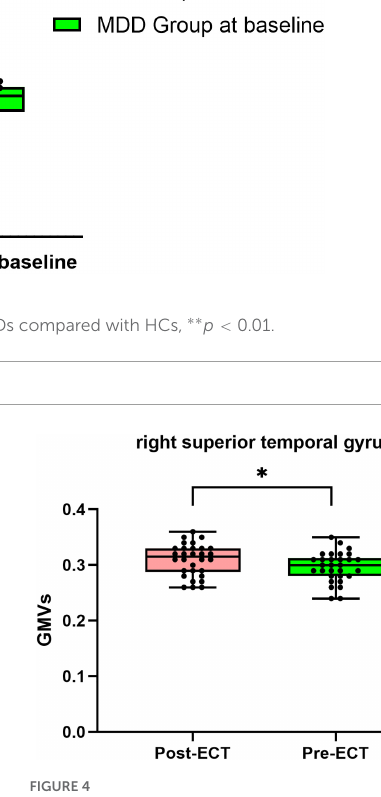
FIGURE3 Red regions mean increased GMVs in the right superior temporal gyrus and right superior frontal gyrus of MDDs after ECT (GMV voxel was p < 0.001; the significance level was p < 0.05 with GRF correction).